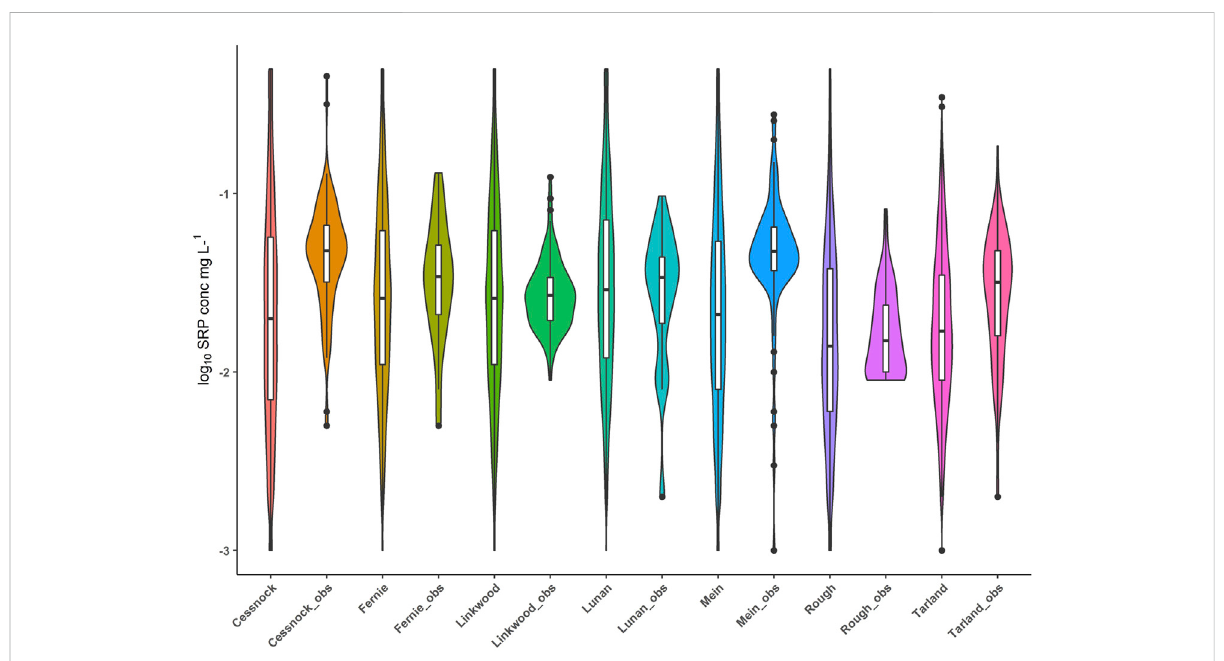
FIGURE 5 Simulated vs. observed SRP concentrations mg L − 1 at the outlet of the seven study catchments showing a greater uncertainty in simulated than observed SRP concentrations. The box plots show the median and inter-quartile range, the whiskers show the minimum and maximum values, and the violin width shows the probability density